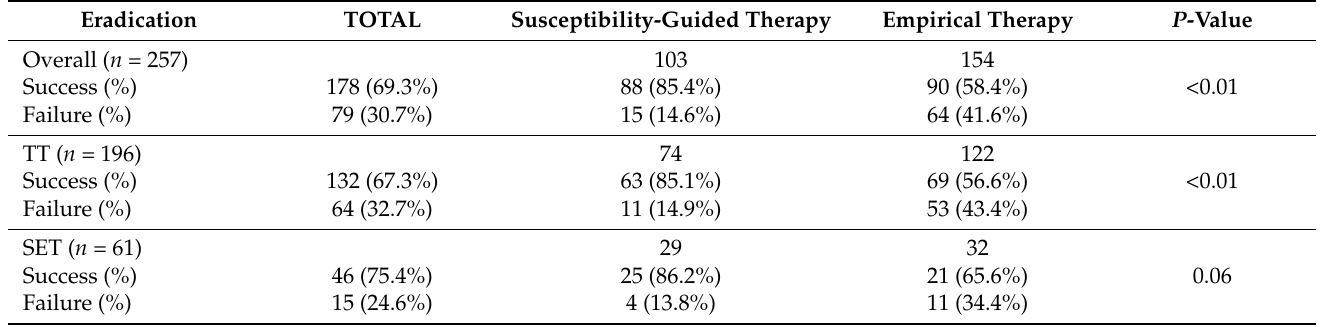
Table 2. Eradication rates comparing susceptibility-guided therapy with empirical therapy.